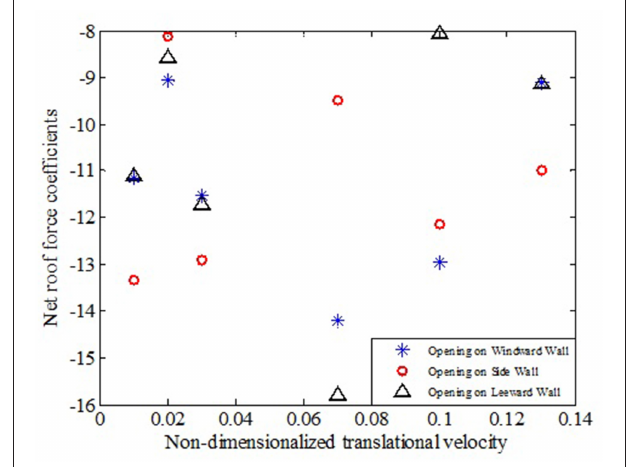
FIGURE 12 | Lowest minimum net peak roof force coefficients for openings located on different